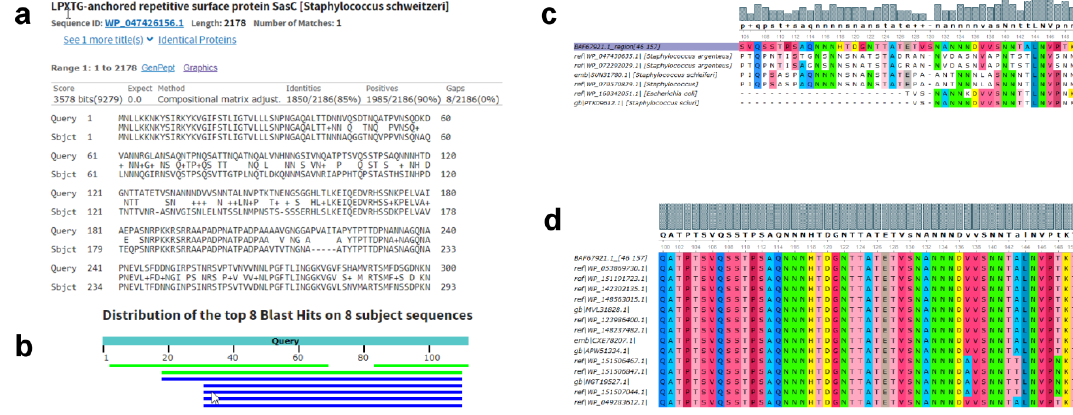
Figure 1. Sequence specificity and conservation of the NWMN_1649 polypeptide. ( a ) Snapshot of the sequence alignment of the first 300 aa of the NWMN_1649 (Query) and its closet matches as determined by the NCBI BLASTp tool. ( b ) Snapshot of the color-coded alignment of the region between aa 46 and 157 of NWMN_1649 and bacterial species other than S. aureus as determined by the NCBI BLASTp tool ( c ) Multiple sequence alignment of the target peptide and its closest matches. ( d ) Multiple sequence alignment of the target peptide blast search hits exclusively against multiple S. aureus strains. Multiple sequence alignments in ( c , d ) were generated using Clustal Omega. The height of the gray bars above the alignment represents the degree of conservation .